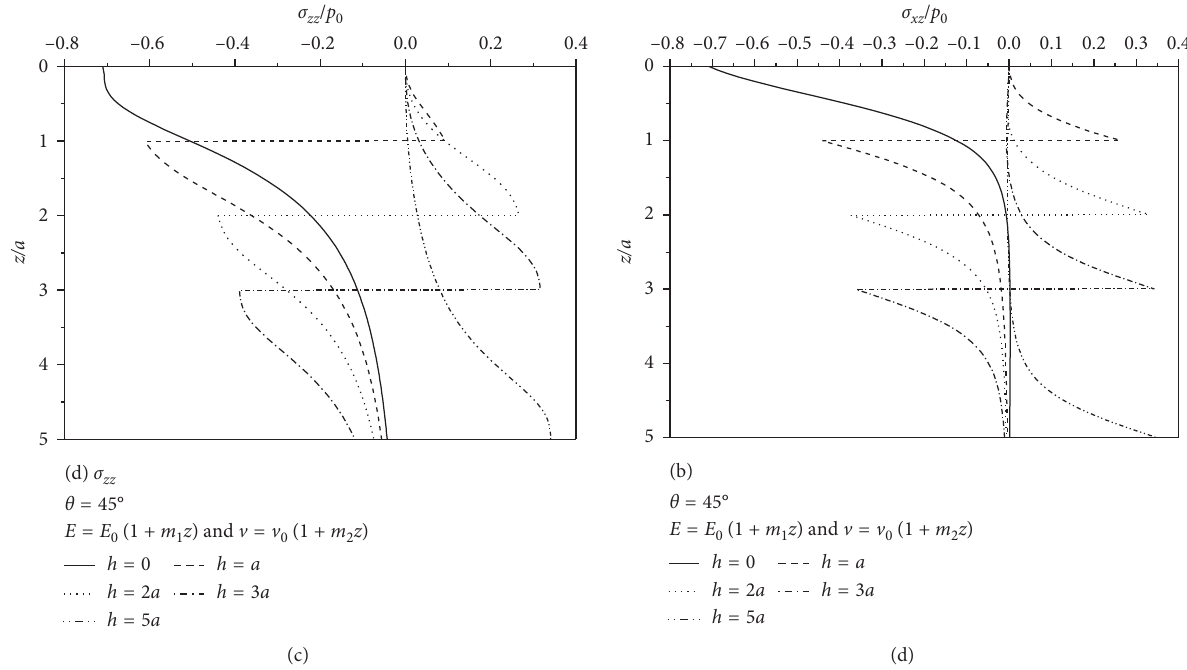
Figure 10: Variations of the four stress components for d � a and θ � 45 ° for different h . (a) σ